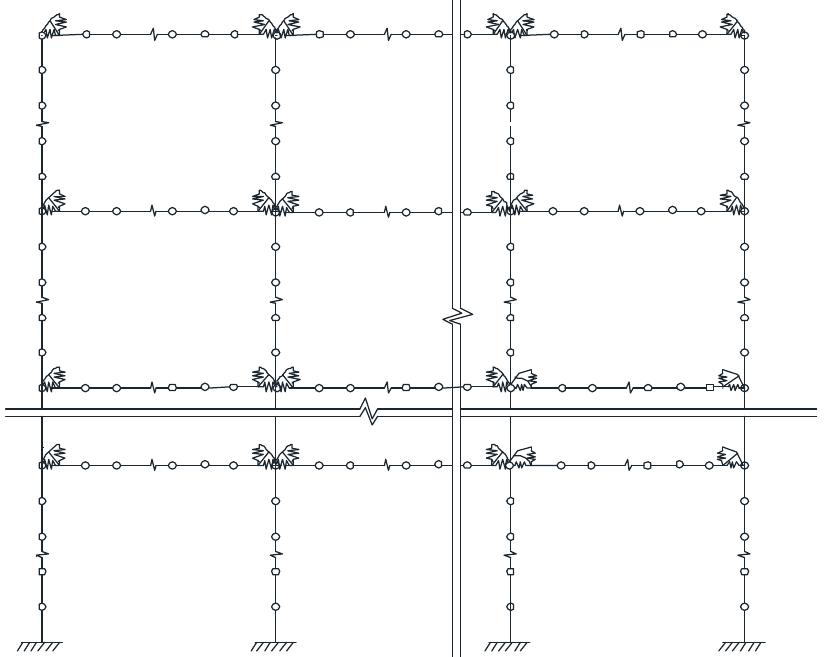
Figure 2: Mechanical model of frame